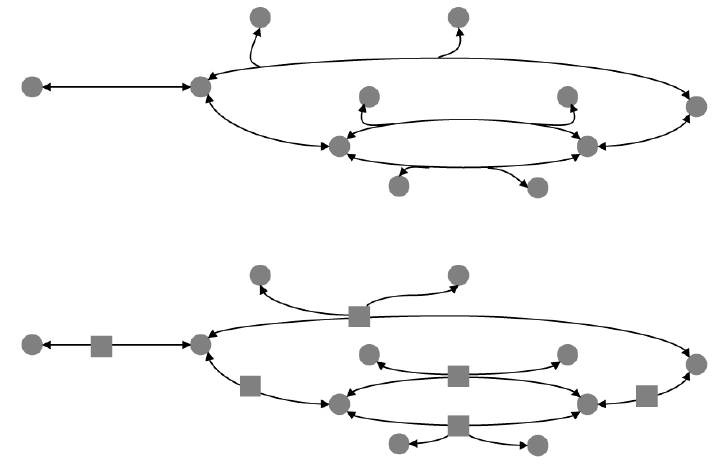
Fig. 2. This picture shows: top - a directed hyper-graph representation of the metabolic pathway of Fig. 1; bottom - a bipartite graph representation of the same